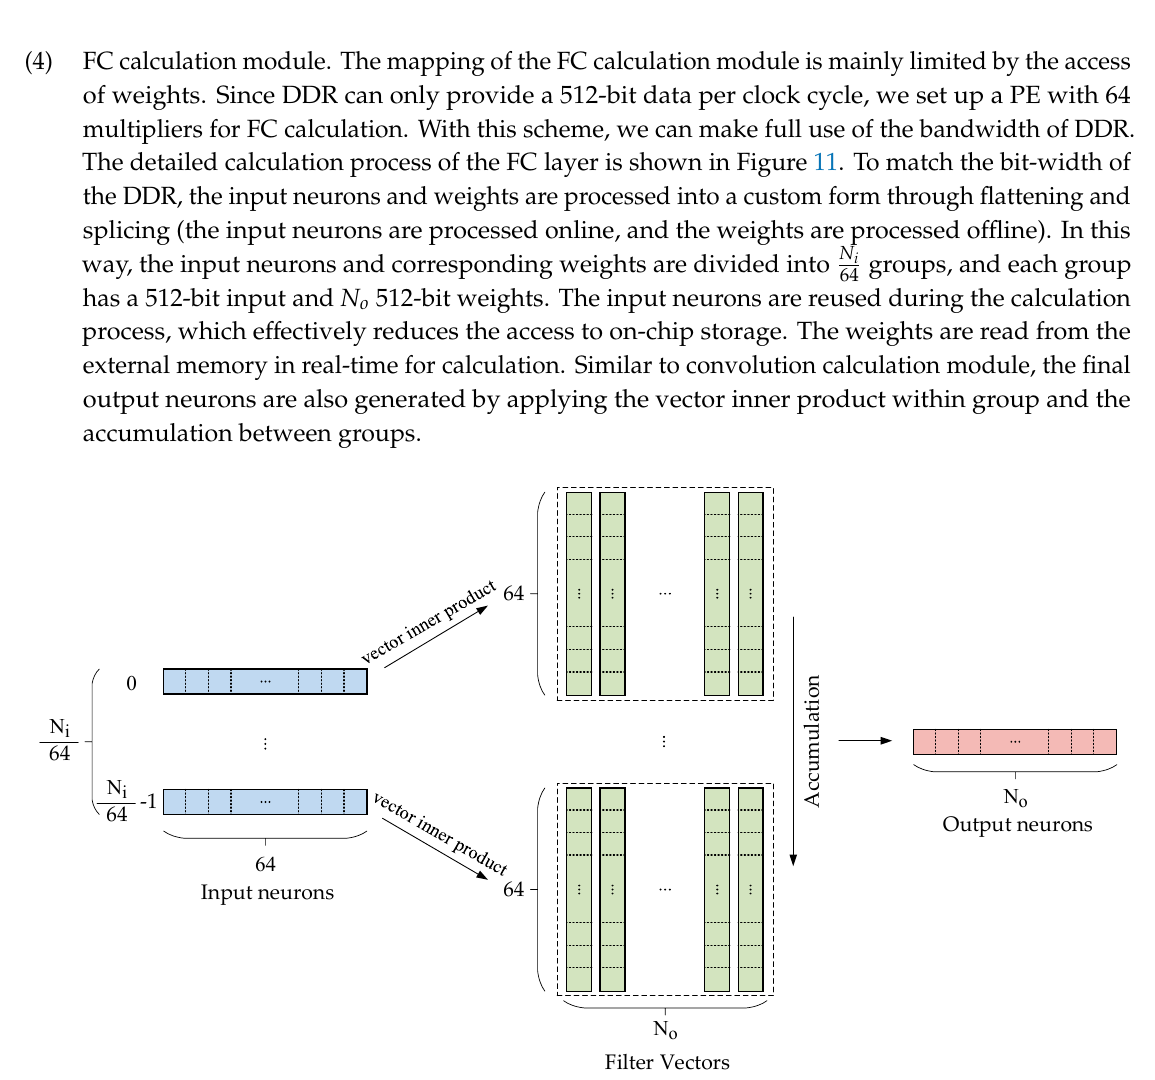
Figure 11. The calculation process of each FC layer. N i and N o are the number of the input neurons and output neurons, respectively.